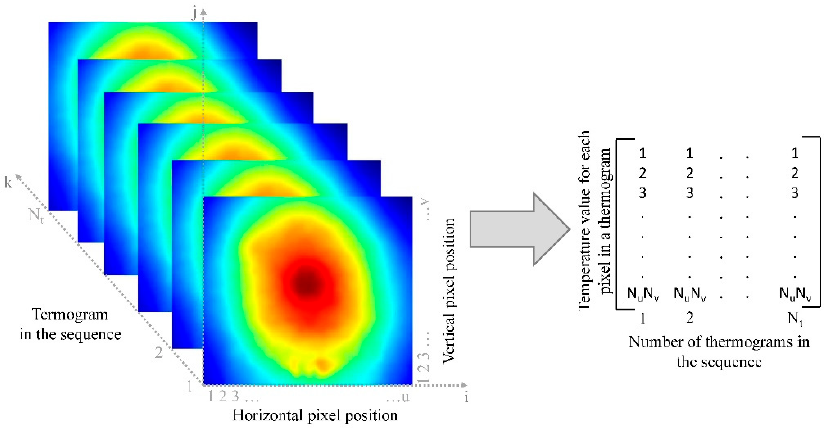
Figure 1. Formation of a 2D raster-like matrix from a thermogram sequence.